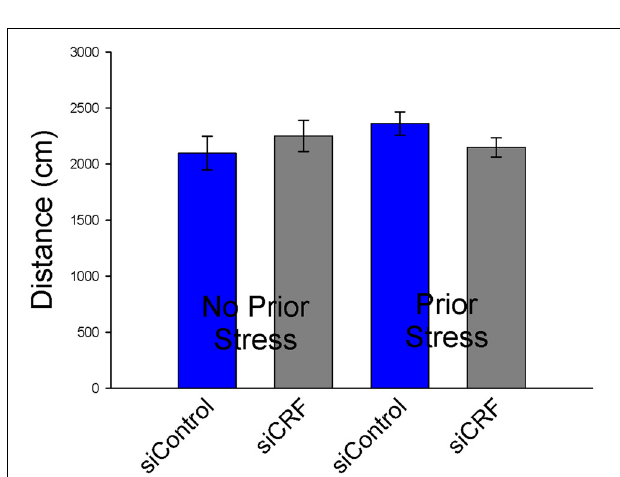
FIGURE 7 | Number of entries into center ( ± SEM), a measure of anxiolytic behavior, were not affected by siRNA treatment or restraint stress.